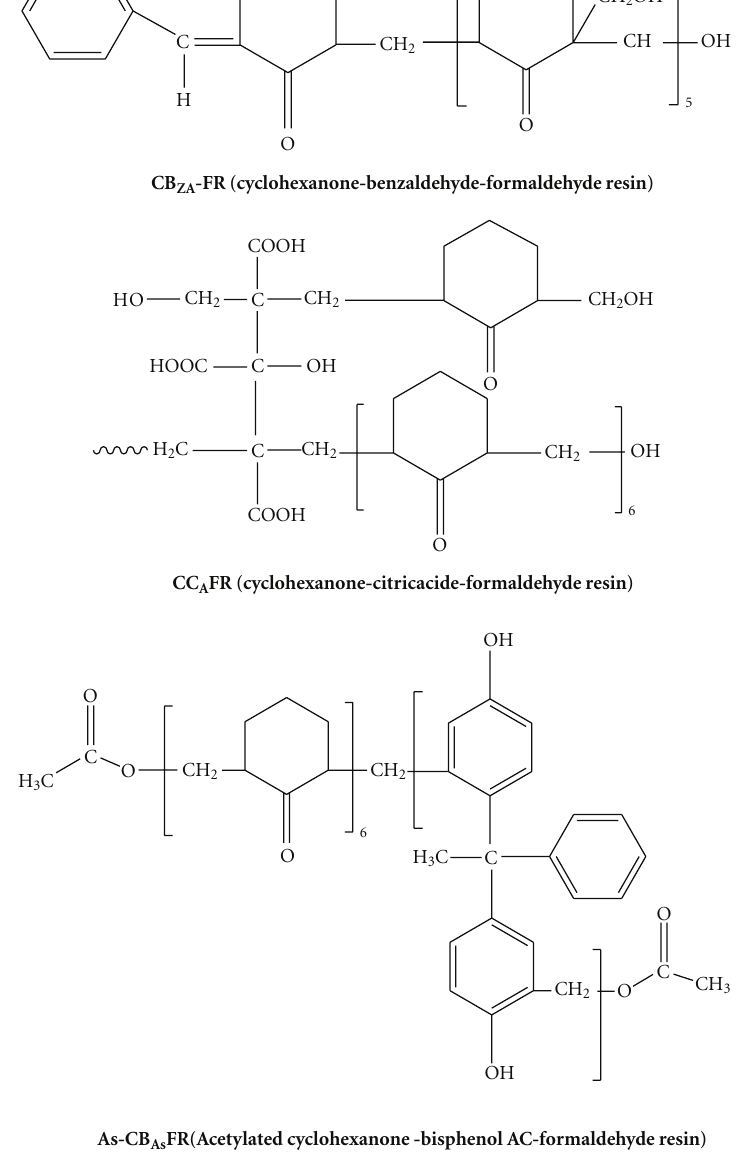
Scheme 3: The molecular structure of the third group resins(CB ZA -FR, CC A F, As-CB Ac FR).